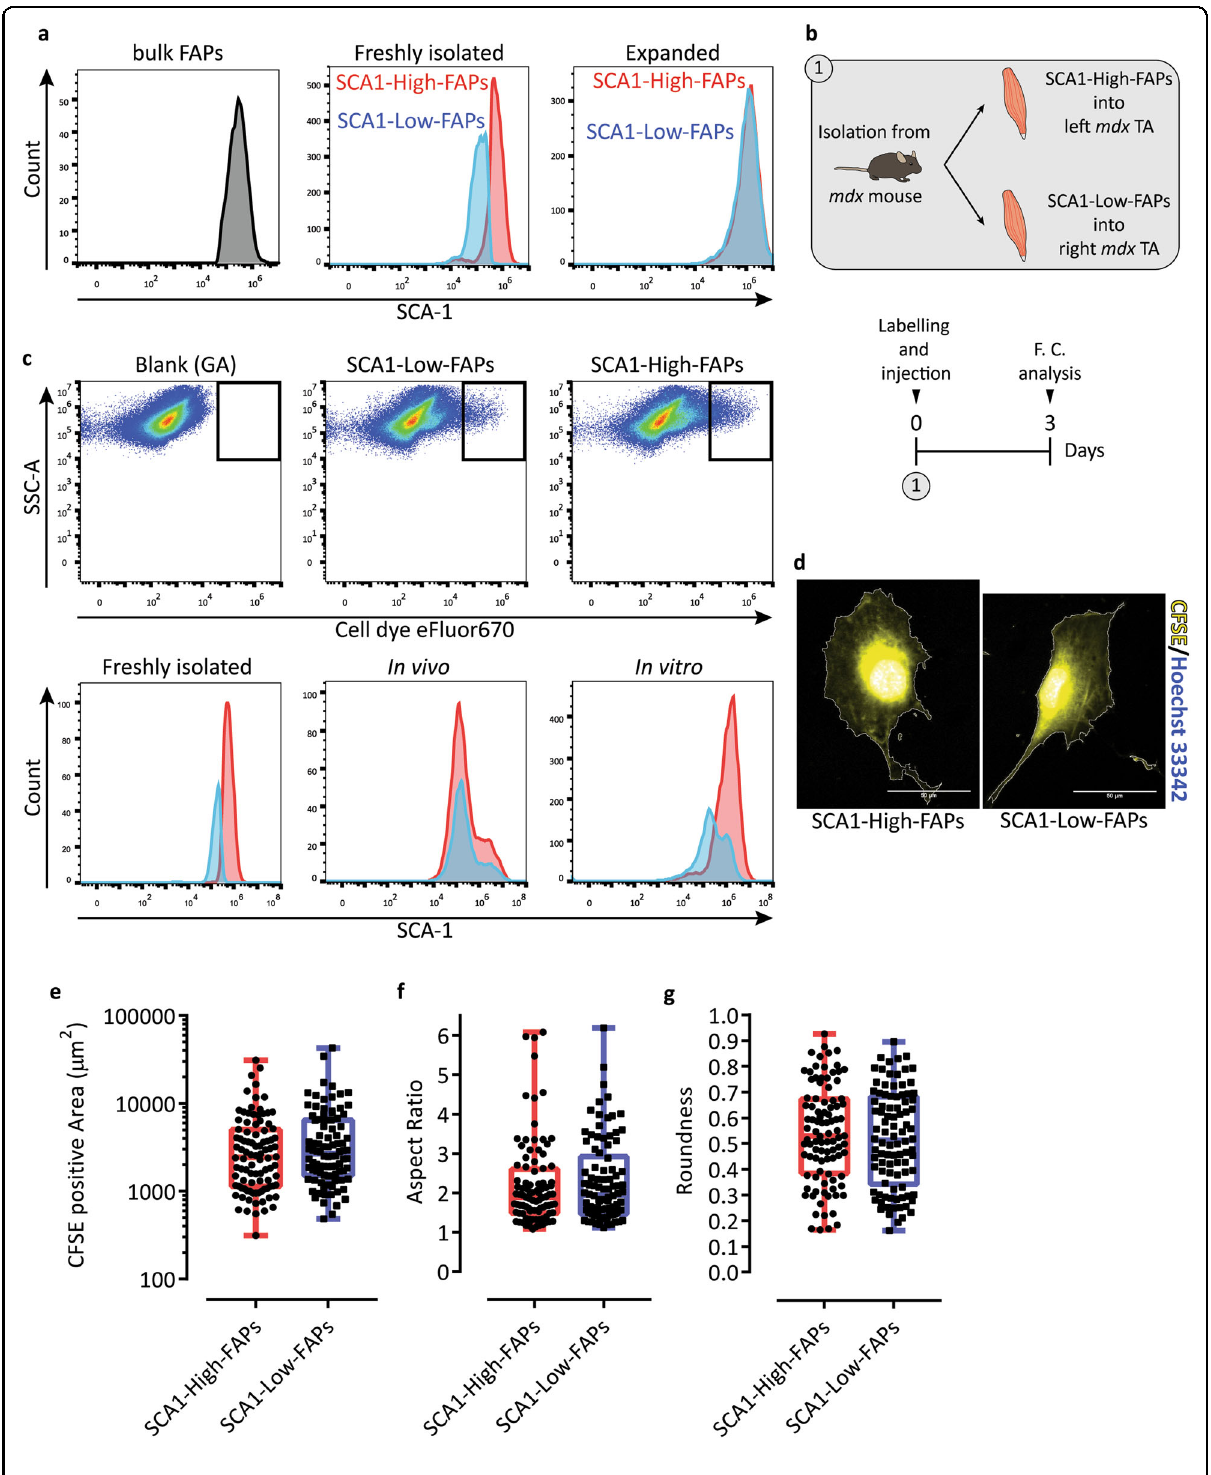
Fig. 2 (See legend on next